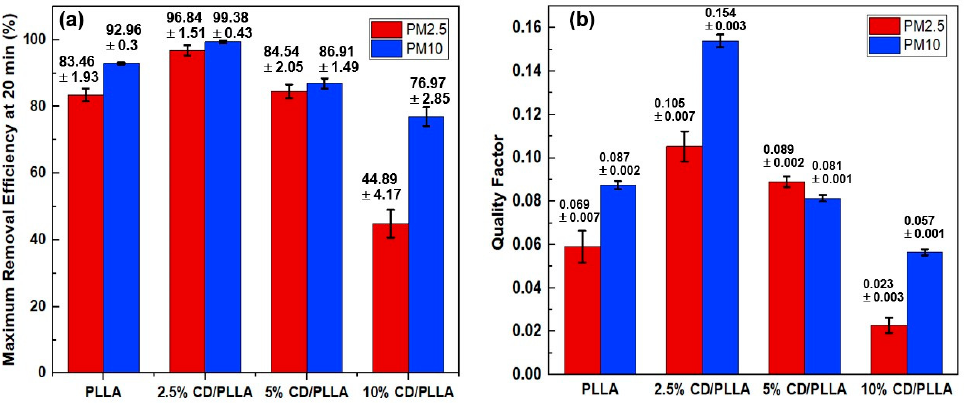
Figure 8. ( a ) PM 2.5 and PM 10 removal efficiency and ( b ) quality factor of PLLA and CD/PLLA nano- fibers.